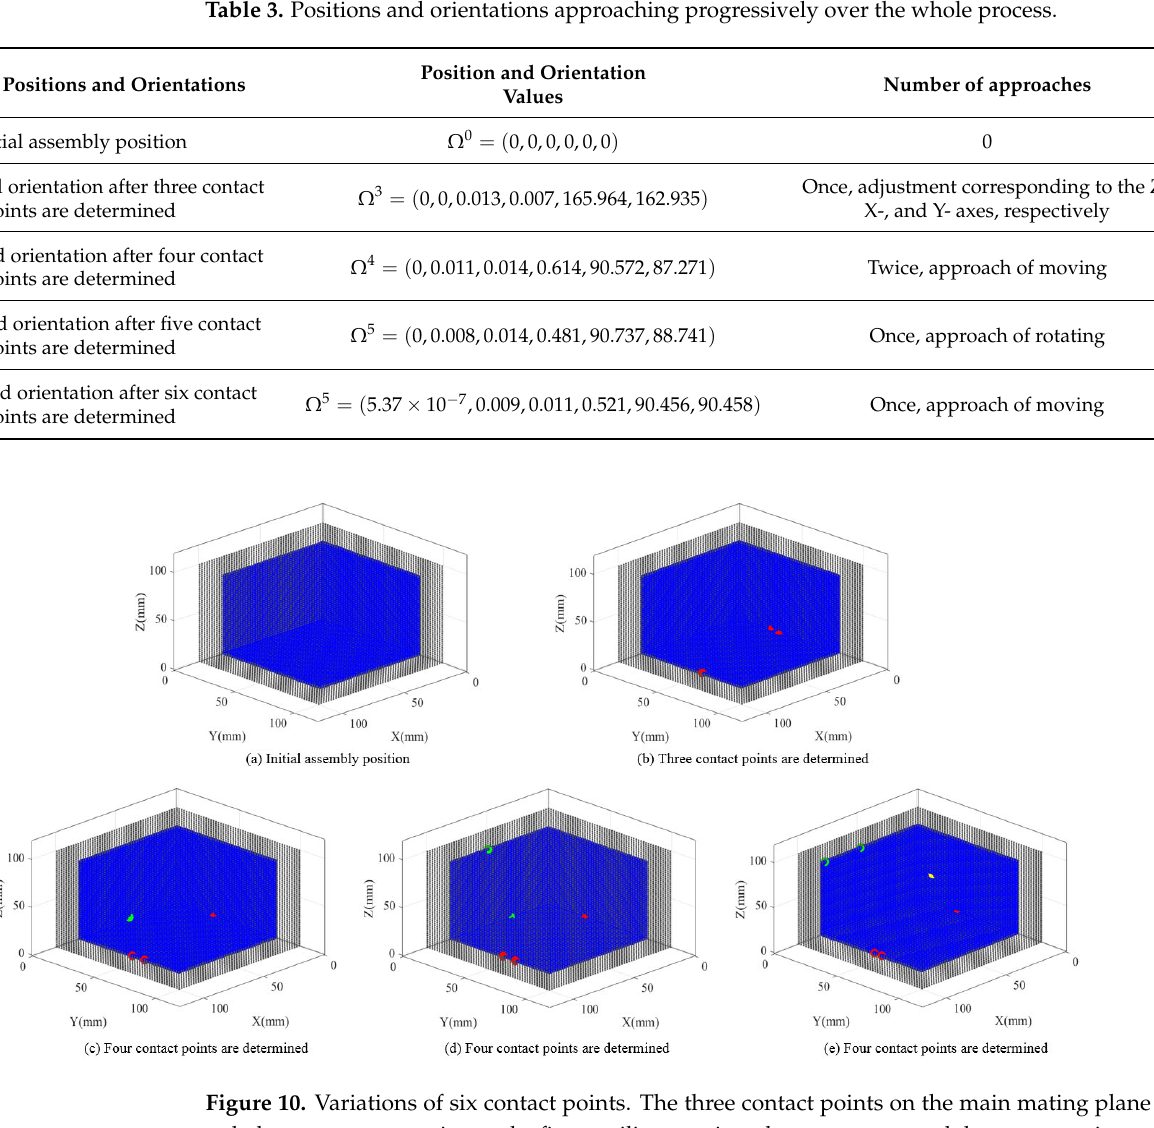
Figure 11. Determined contact points of the six assembly states. The three contact points on the main mating plane are red, the two contacts point on the first auxiliary mating plane are green, and the contact point on the second auxiliary mating plane is yellow. Table 4. Acquired position and orientation deviations (PODs) of the assembly with three mating planes. Assembly States PODs Deviaitons along X ‐ Axis (mm) Deviaitons along Y ‐ Axis (mm)